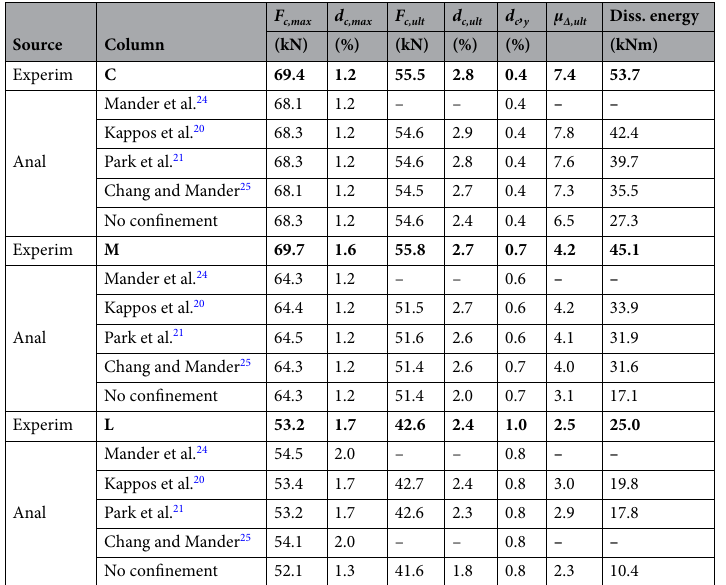
Table 5. Maximum and ultimate lateral force and corresponding drift, drift at yield strength and ductility at ultimate strength. Experimental values are in